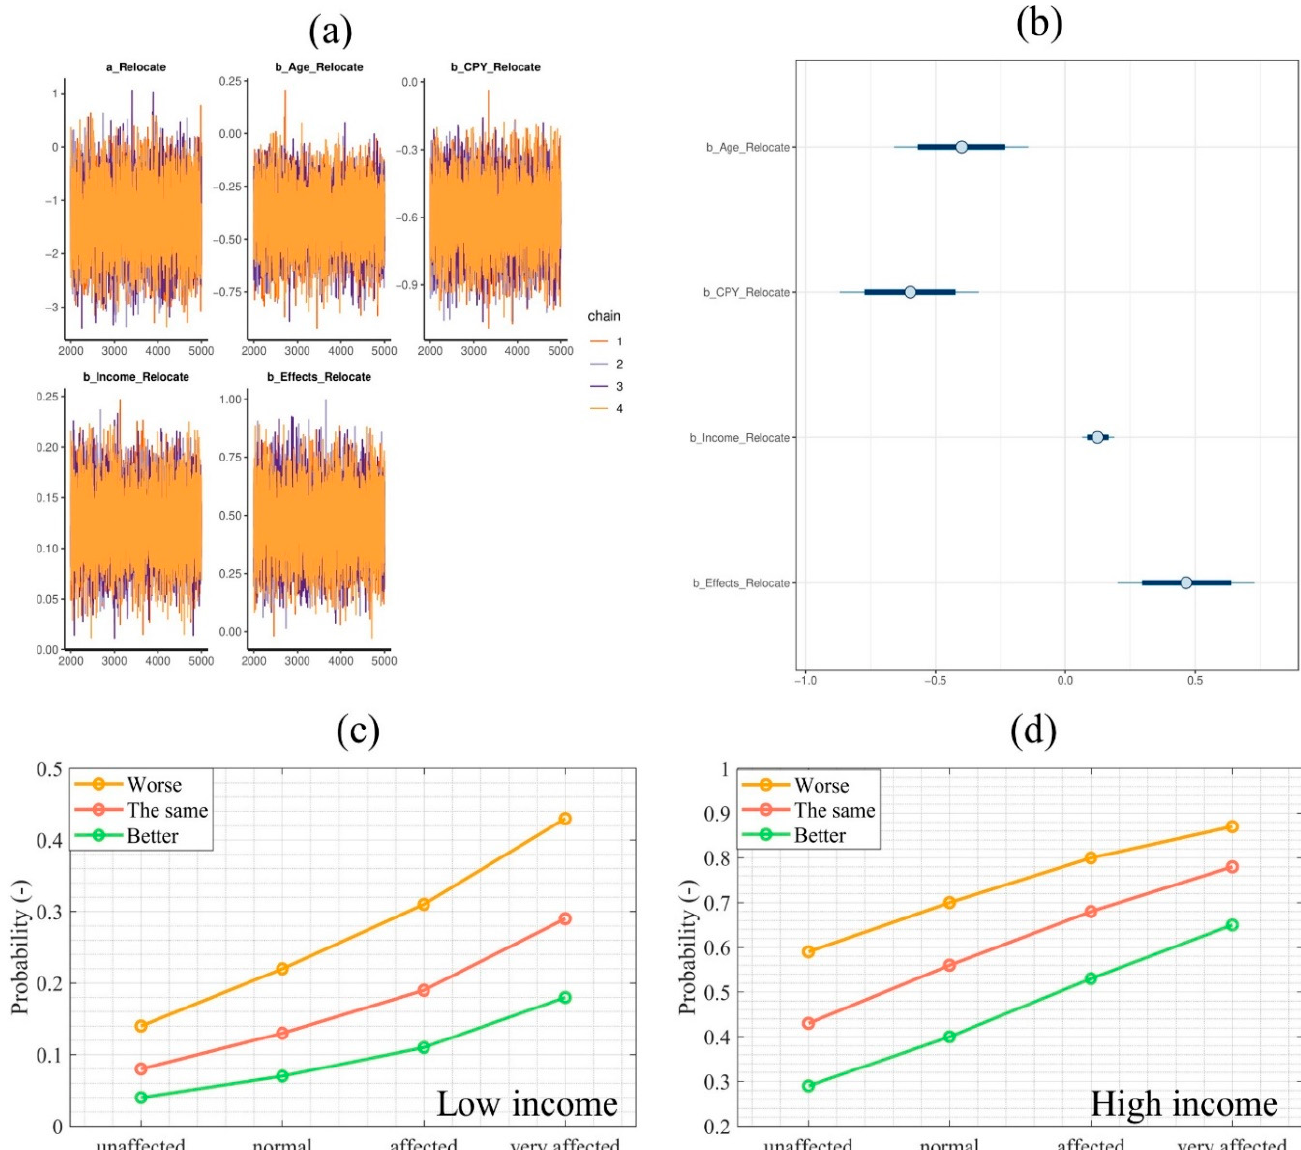
Figure 5. Trace plots for Model 3’s posterior parameters ( a ), distribution of posterior coefficients estimated with uninformative priors ( b ), probabilities of relocating based on perceived changes in environment over time and of low ( c ) and high ( d ) income households.